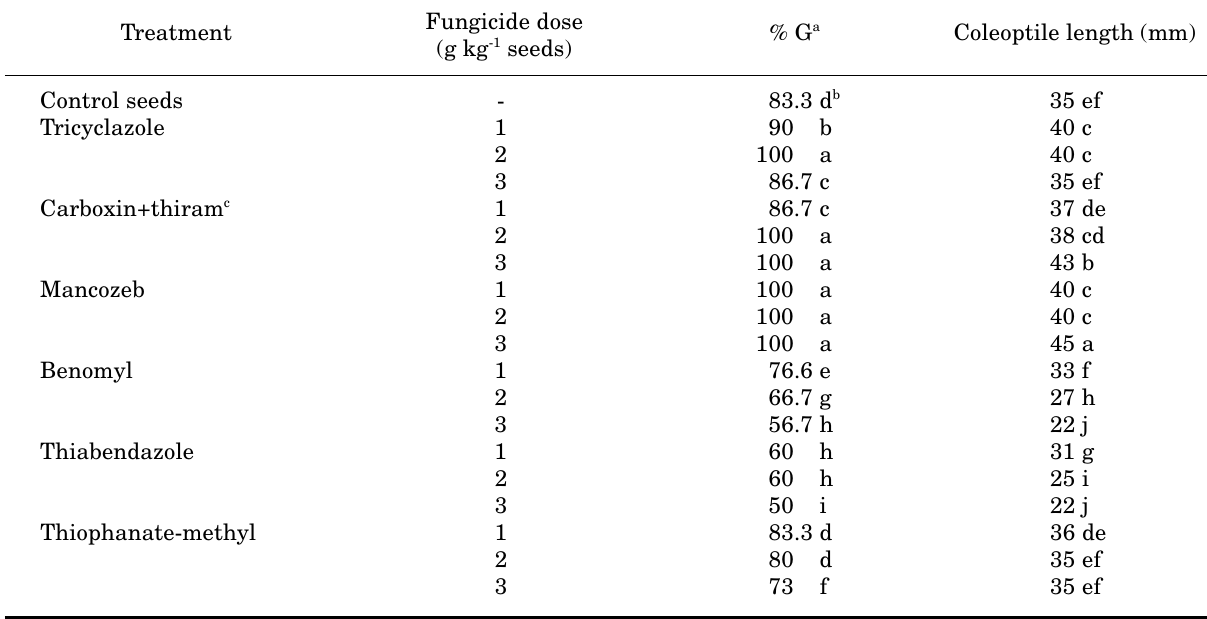
Table 3. Percent germination of rice seeds treated with fungicides, and coleoptiles length of the plants grown from such